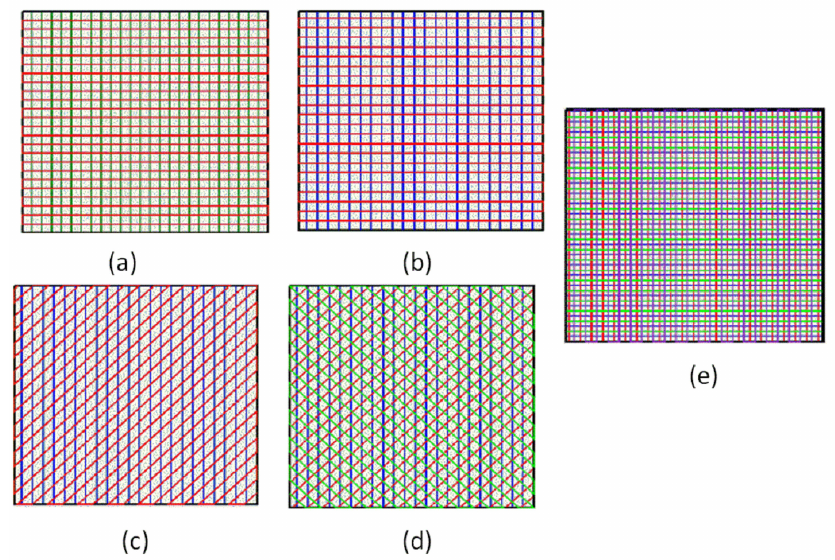
Figure 13. Di ff erent internal structure patterns of sca ff olds. ( a ) 0 / 90 degree sca ff olds with 1 mm spacing; ( b ) 0 / 90 degree sca ff olds with 1.2 mm spacing; ( c ) 0 / 45 degree sca ff olds with 1.2 mm spacing; ( d ) 0 / 45 / 135 degree sca ff olds with 1.2 mm spacing; ( e ) staggered sca ff olds with 1.2 mm